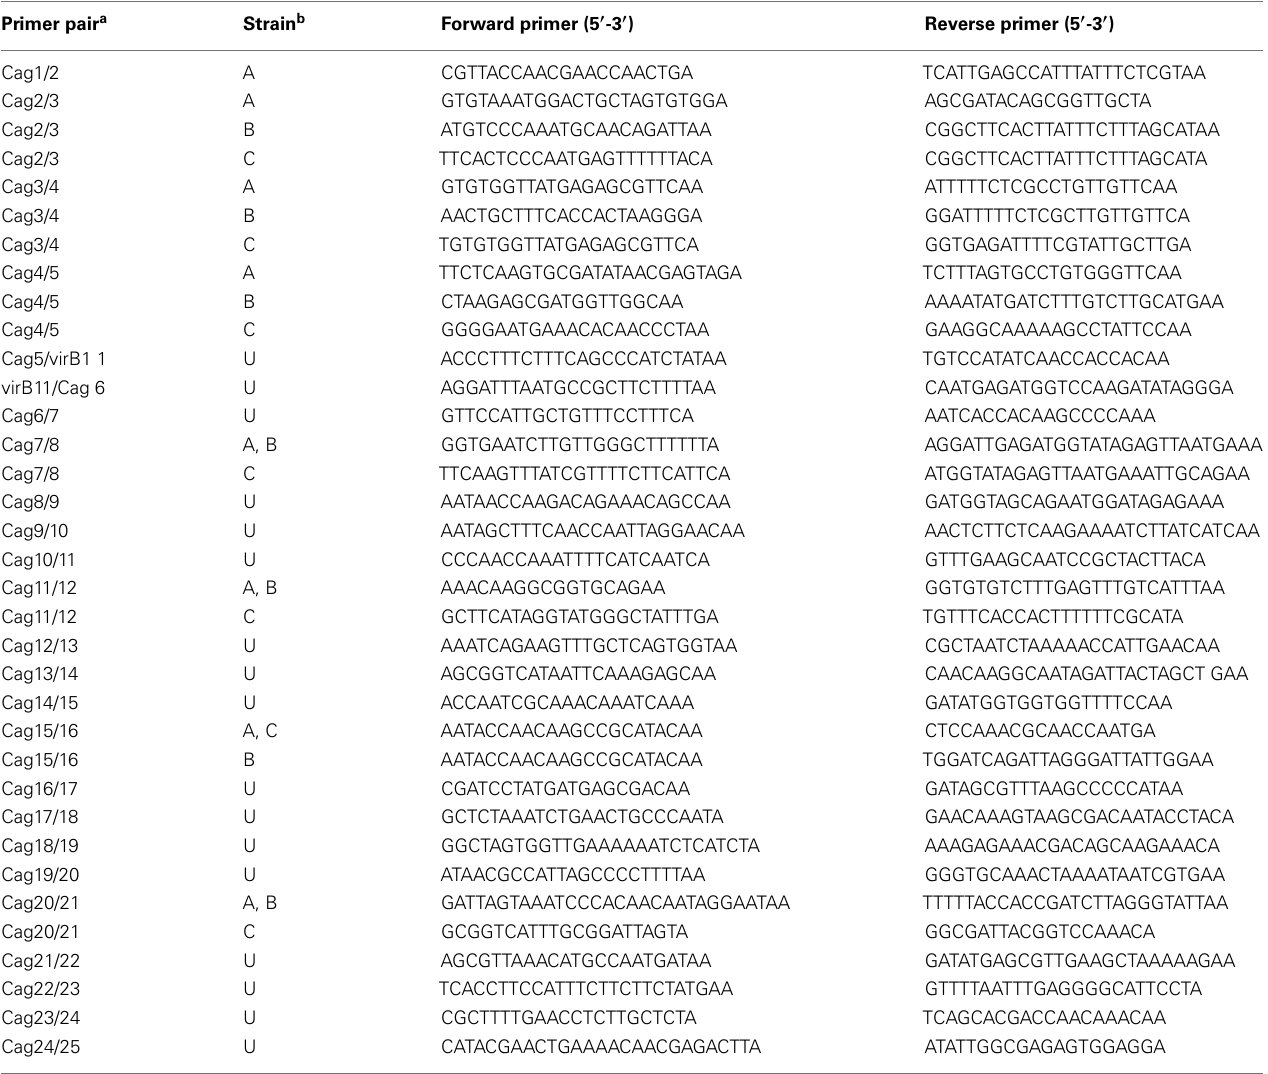
TableA2 | Intergenic primer pairs selected for real time RT-PCR. Primer pair